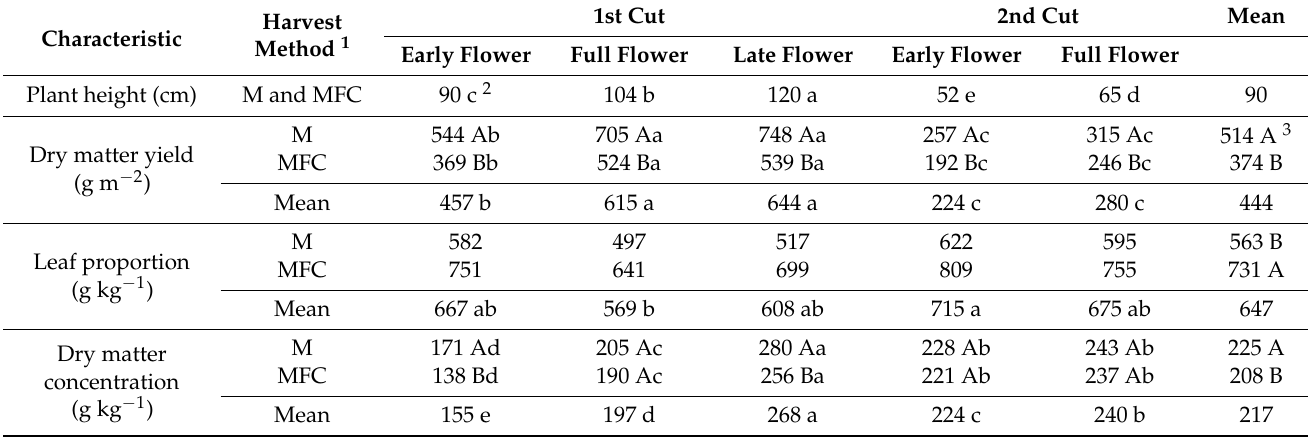
Table 3. Plant height, dry matter yield, leaf proportion, and dry matter concentration of galega at two cuts and three maturities, depending on harvest method (mean over two years). 1st Cut 2nd Cut Mean Harvest Characteristic Method 1 Early Flower Full Flower Late Flower Full